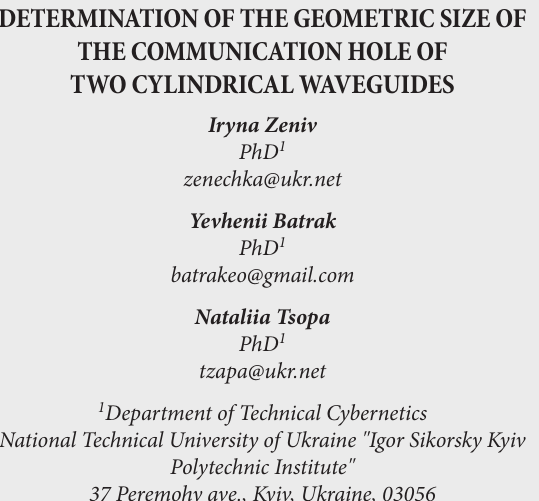
Fig. 1. Projections of two connected hollow cylindrical